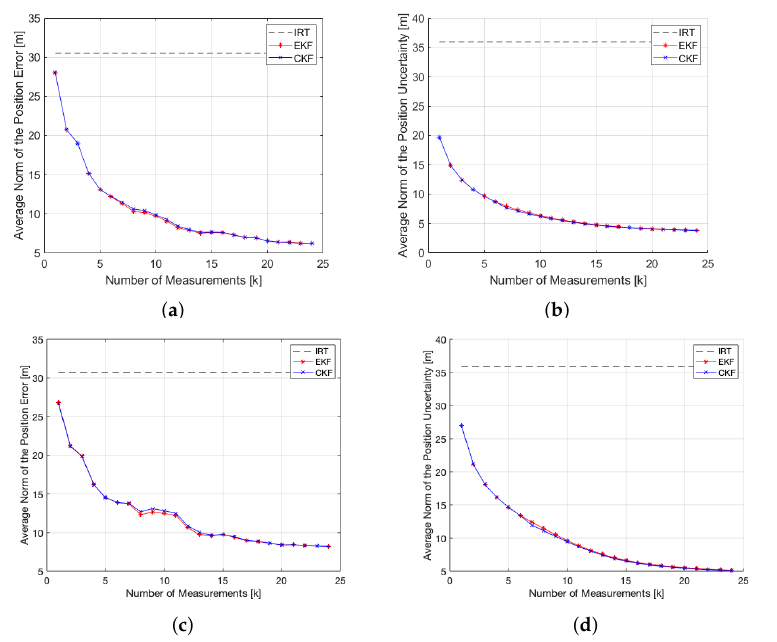
Figure 6. EKF and CKF filtering results for the rough terrain simulation. ( a ) BR-EKF and BR-CKF average norm of the position error; ( b ) BR-EKF and BR-CKF average norm of the position uncertainty; ( c ) BO-EKF and BO-CKF average norm of the position error; ( d ) BO-EKF and BO-CKF average norm of the position